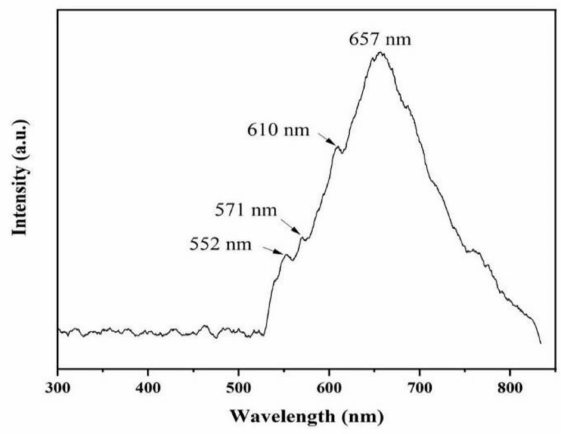
Figure 8. Room-temperature PL spectrum of AlN